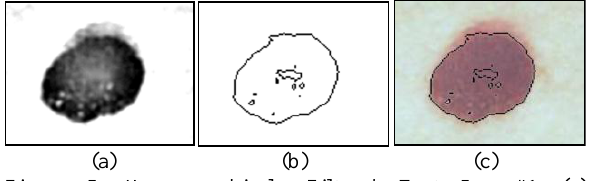
Figure 5. Homomorphicaly Filtered Test Image#1 (a) Photocopy filter (Det: 24, dark:5) (b) Trace Cont. (Level, Edge Lower:128) (c) overlay with original image